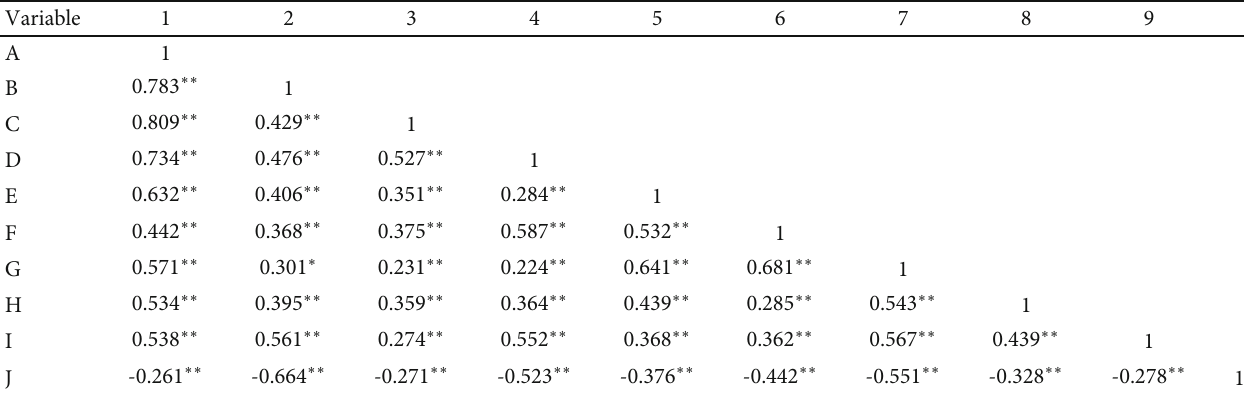
Table 1: Statistical results of the correlation coe ffi cients of the variables.